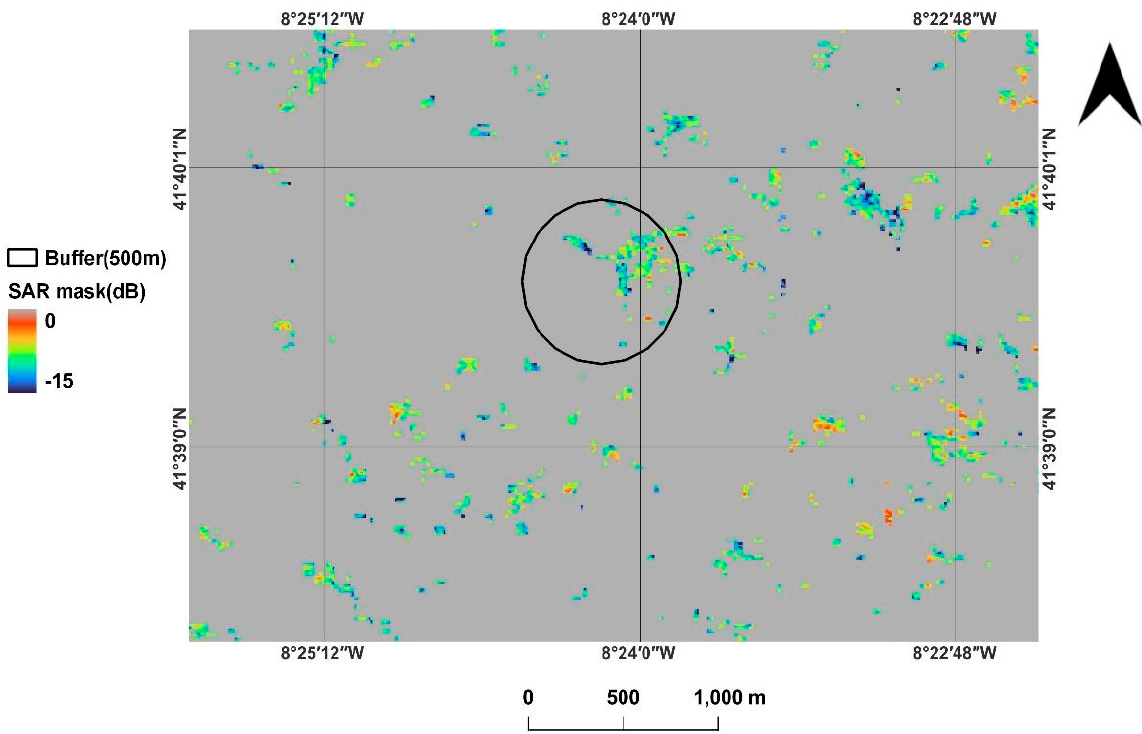
Figure 5. 500 m buffer geometry from DC pixel centers overlapping the masked SAR data. SAR backscatter values were correlated to DC values at the time of the image.